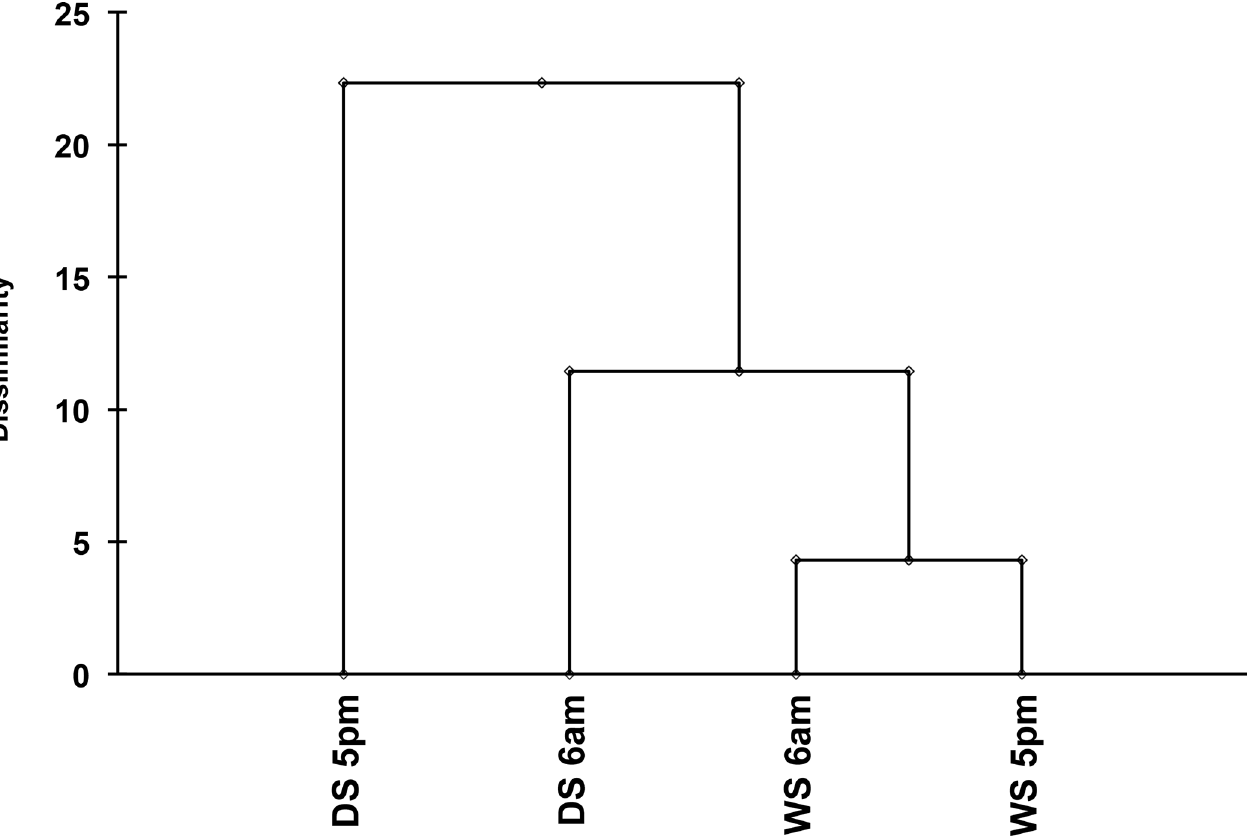
Fig 2. Agglomerative Hierarchical Clustering (AHC) calculated with the Ward ’ s linkage and Euclidean distance, which correlates the essential oil data from a semideciduous seasonal forest. Wet Season at 6:00 am (WS 6am) and Wet Season at 5:00 pm (WS 5pm) — Group 1; Dry Season at 6:00 am (DS 6am) — Group 2; Dry Season at 5:00 pm (DS 5pm) — Group 3.